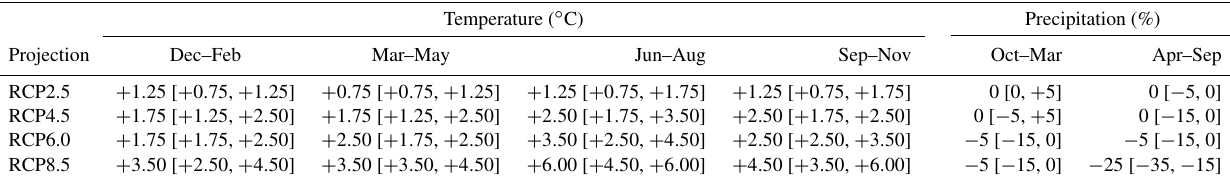
Table 2. Representative concentration pathway (RCP) projections for Mediterranean zones for 2081–2100 as compared with the reference period 1981–2000. RCP values are indicated for each season for temperature and for each semester for precipitation. Values are medians and interquartile ranges [25th, 75th percentiles] (IPCC,